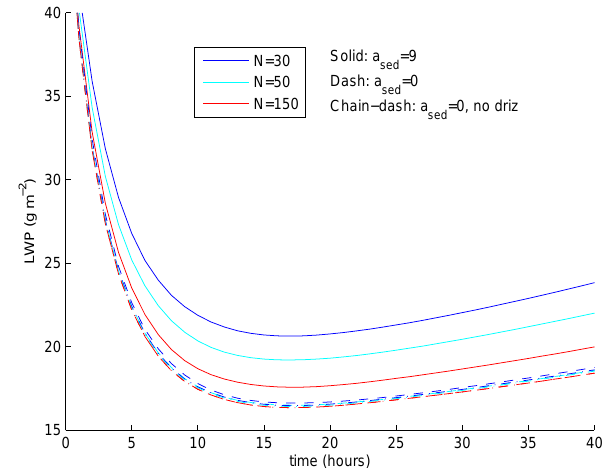
Fig. 8. 40-h time series of MLM-simulated LWP for N =150, 50 and 30cm − 3 with a sed =9 (solid) and a sed =0 (dashed). LES-tuned cloud-base drizzle and a 2 =110 are used. The chain-dash curves, almost indistinguishable from the dashed curves, show the negligible effect of suppressing drizzle on the a sed =0 simulations.